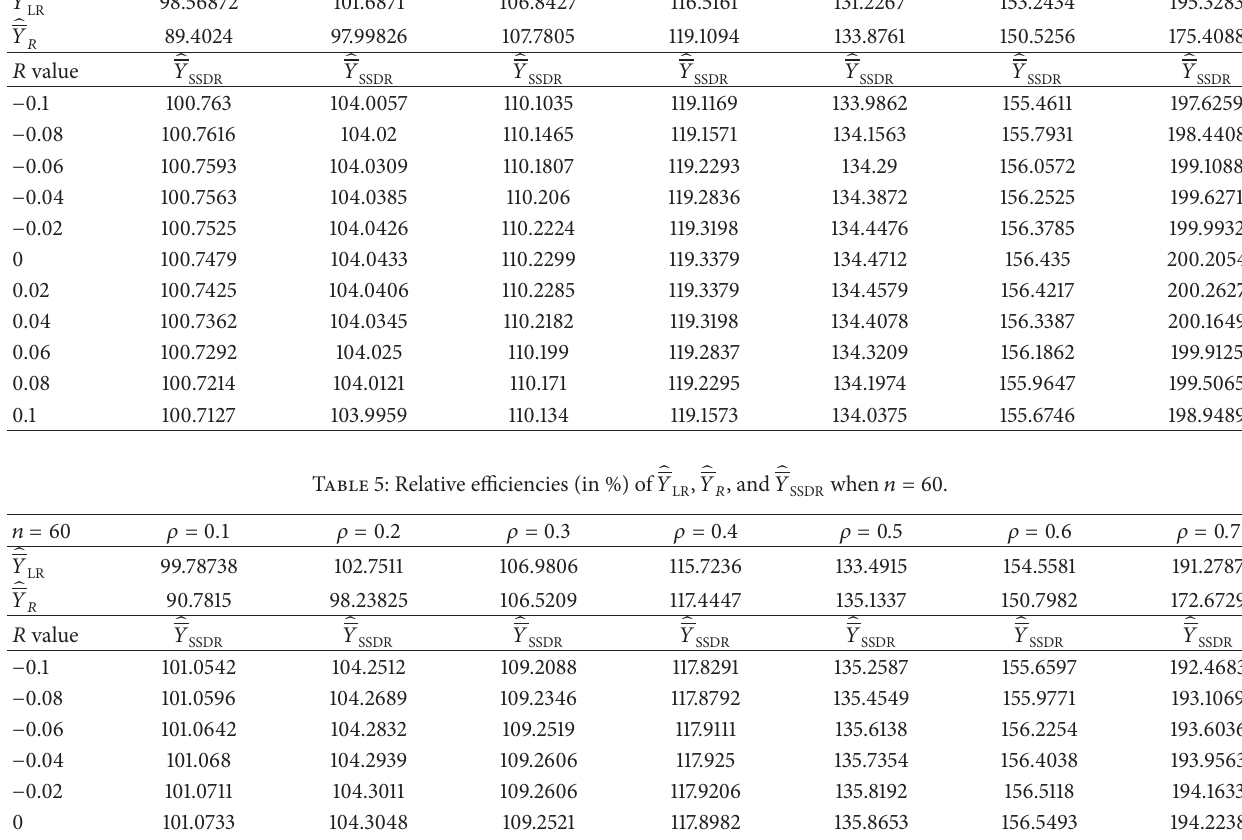
̂ 𝑌 when 𝑛 = 40 . SSDR